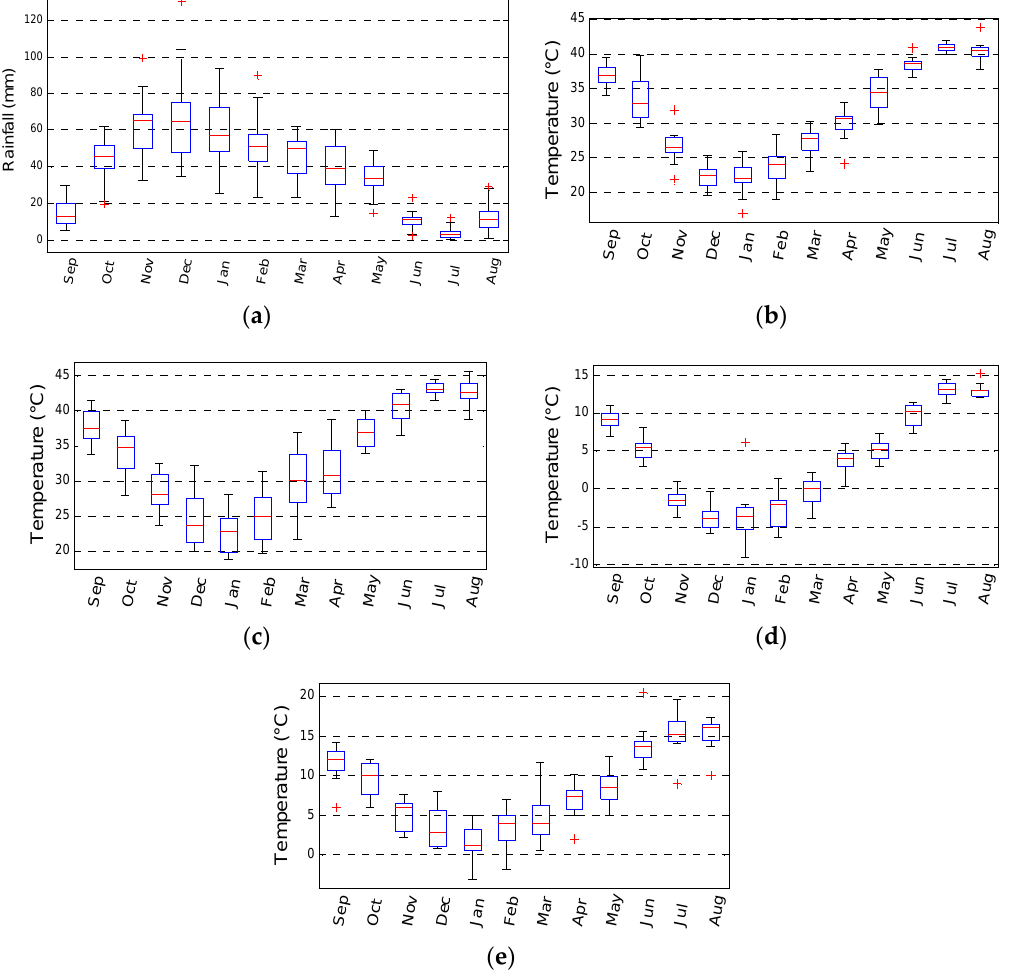
Figure 2. ( a ) Overall inter-annual mean monthly rainfall of the study area (1998–2010); ( b ) and ( c ) Maximal monthly temperature at Tillouguite (1100 m a.s.l.) and Sidi Driss dam’s rain gauge (640 m a.s.l.), respectively (1998–2010); ( d ) and ( e ) Minimal monthly temperature at Tillouguite and Sidi Driss dam’s rain gauge, respectively (1998–2010).